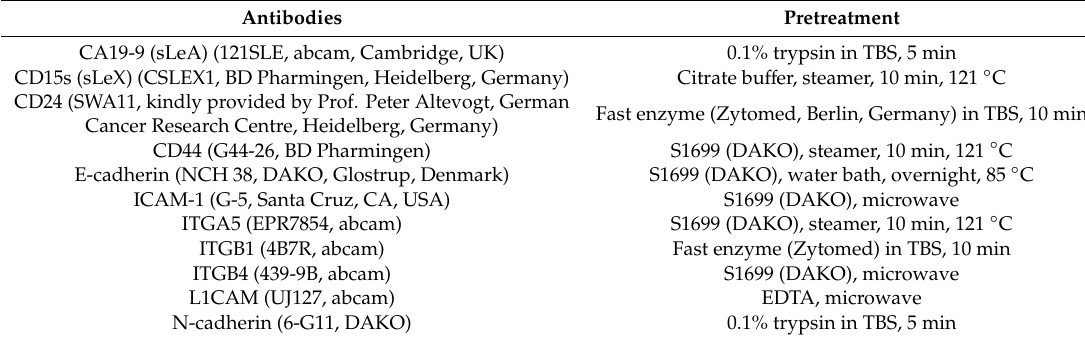
Table 4. Commercial antibodies and pretreatment used for immunohistochemical